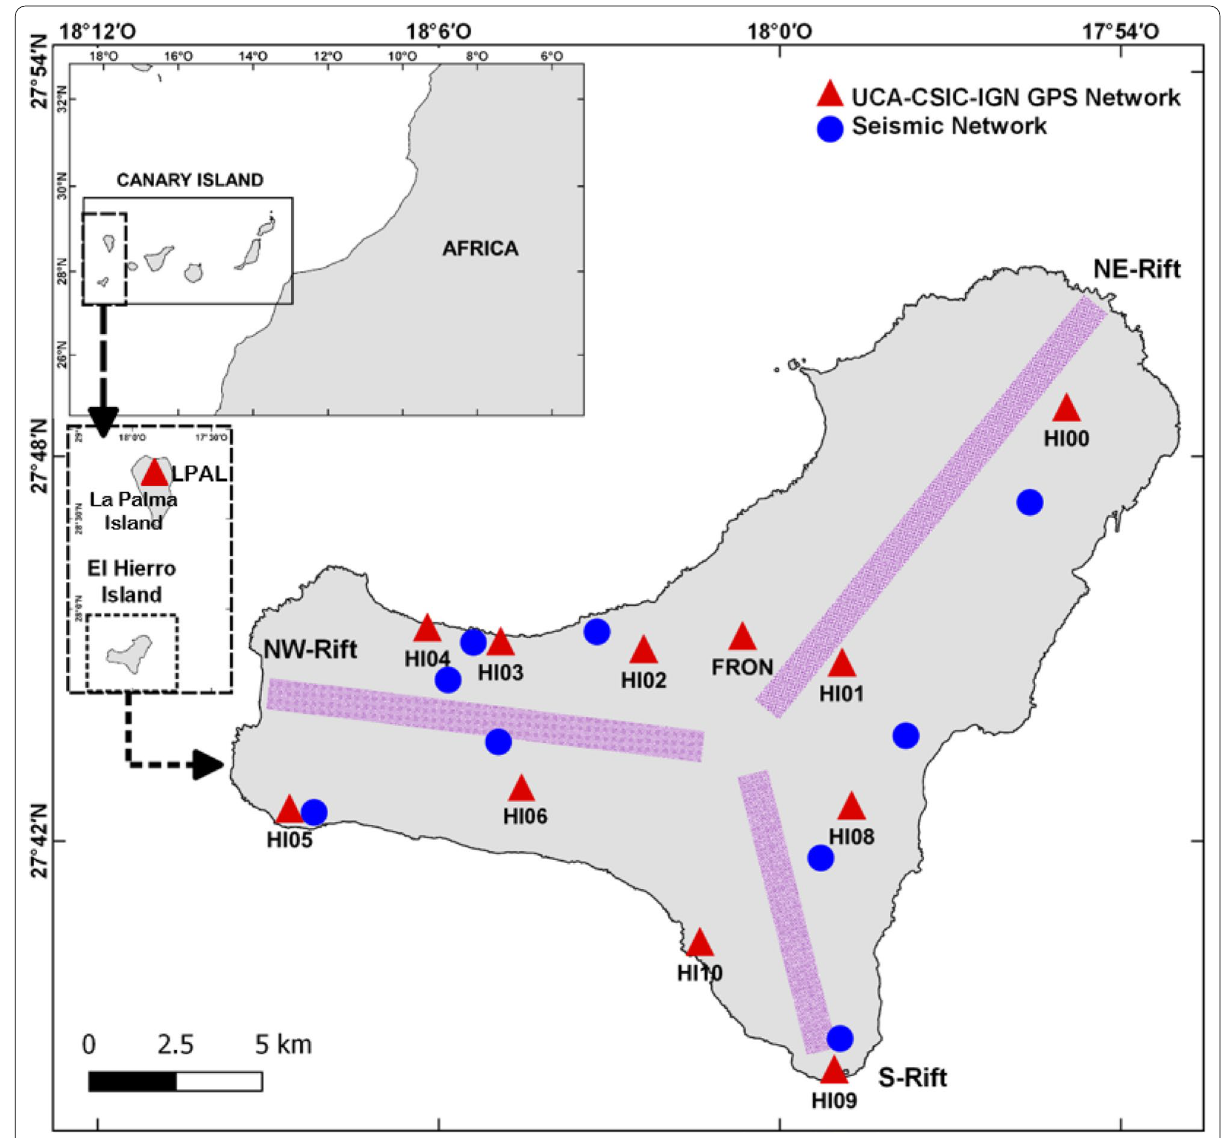
Fig. 1 Geodynamic map of the El Hierro island. In this map the triaxial rift, the GPS stations of the geodynamic network (IGN‑CSIC‑UCA), and seismic stations are shown. The location of the LPAL station (EUREF) in La Palma island and FRON station (GRAFCAN) in El Hierro island can be seen in this